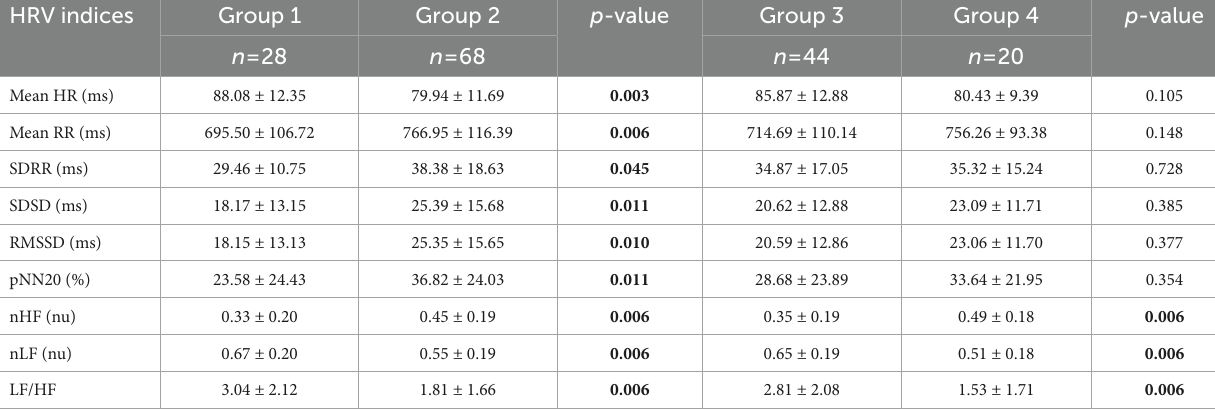
TABLE 3 Comparison of HRV indices between groups 1 and 2, and between groups 3 and 4. HRV indices Group 1 Group 2 p -value Group 3 Group 4 p -value n = 28 n = 68 n = 44 n = 20